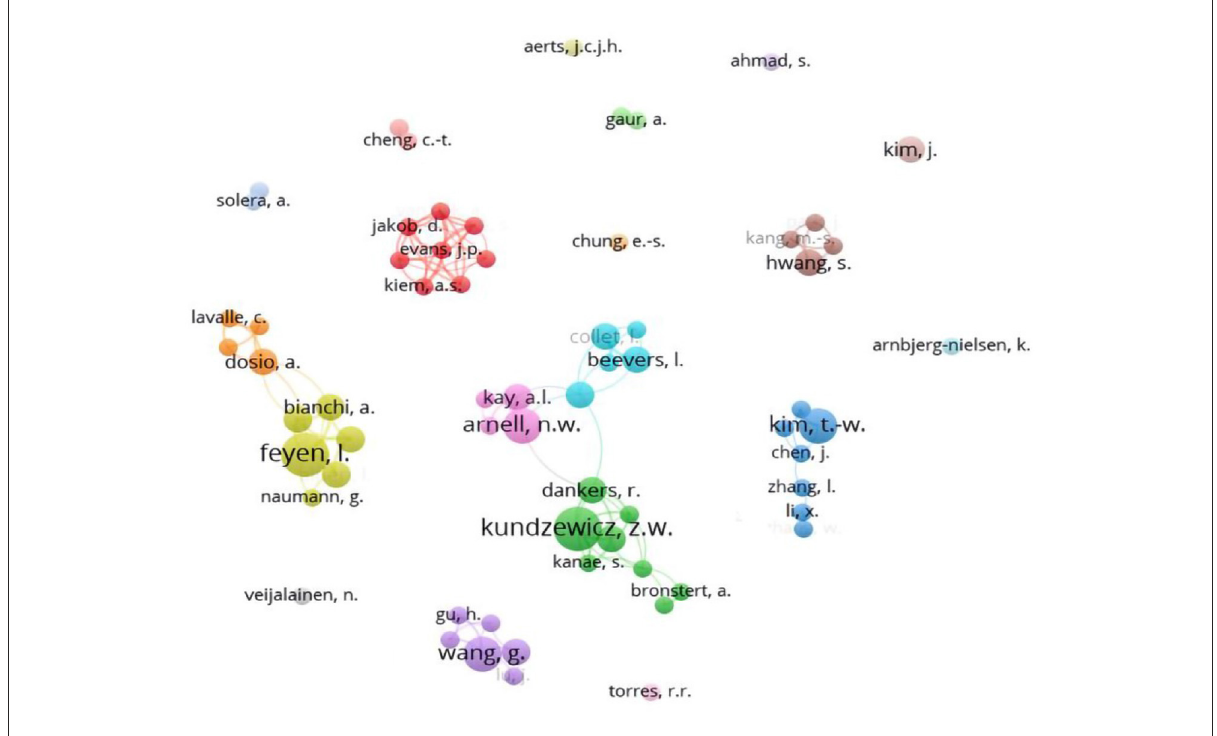
FIGURE7 Author clusters of the reviewed papers.